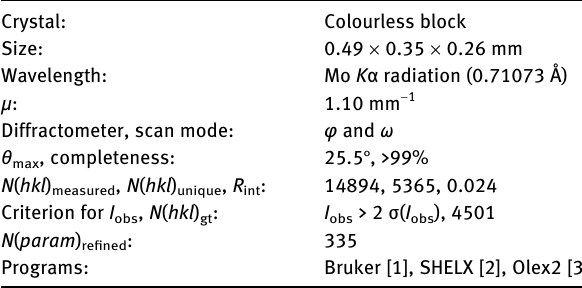
Table  : Data collection and